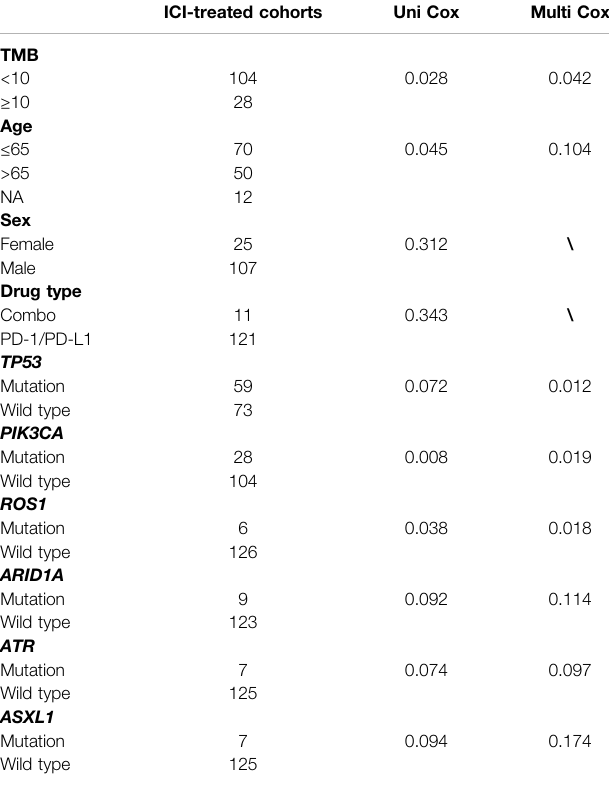
TABLE 1 | Overview of ICI-treated cohort used in this